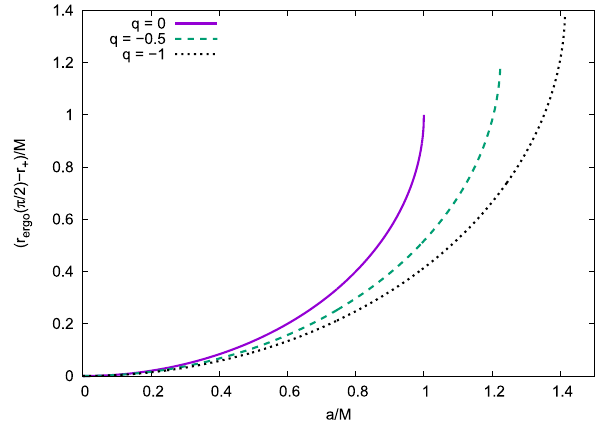
Fig. 1 Size difference between the ergosurface and the event hori- zon at the black hole equator. This illustrates that although ergoregion increases with the tidal-charge intensity, the space between the ergosur- face and the event horizon of black holes with tidal charge is smaller than that of Kerr black holes with same angular momentum (cid:5) M 2 − β . For and extreme black holes have a c =